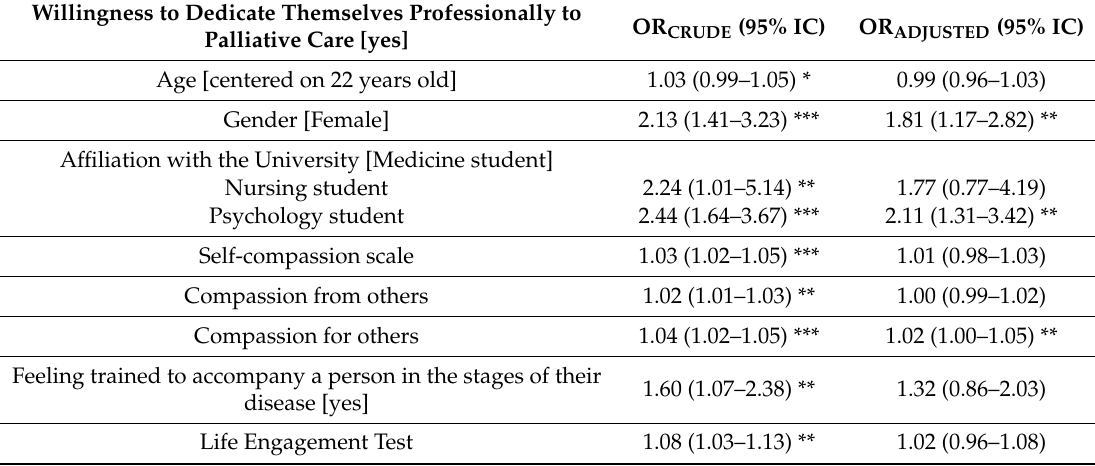
Table 9. Willingness to dedicate themselves professionally to Palliative Care among Medicine, Nursing and Psychology students (n = 459). Univariate and multivariate regression